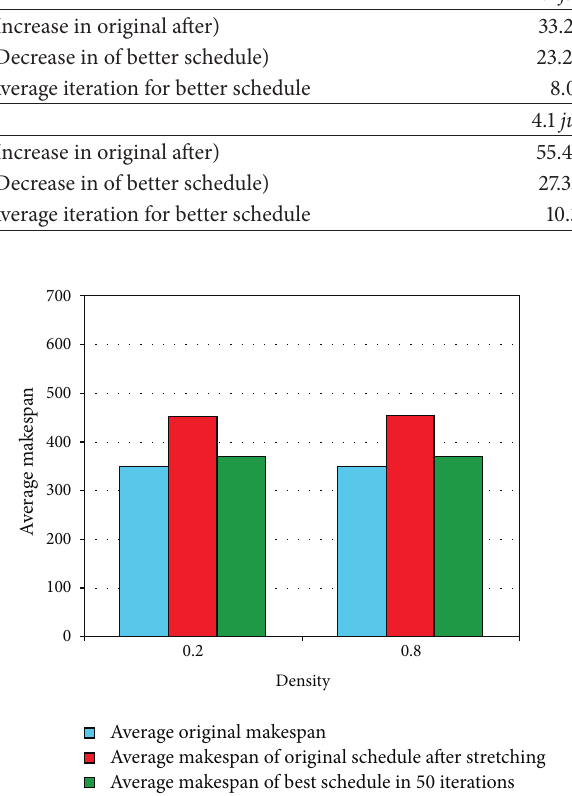
Figure 15: Results for DAGs with different values of density .